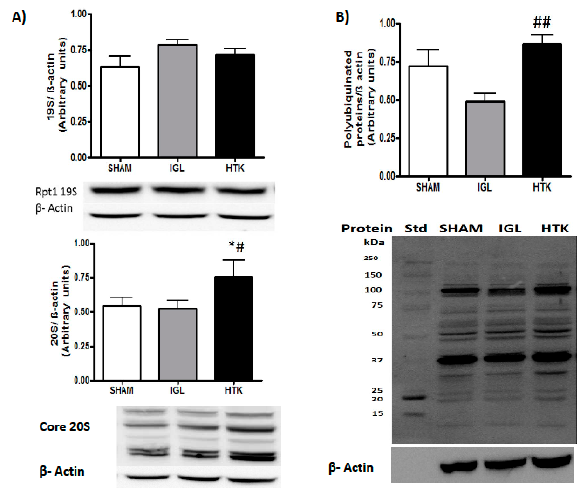
Figure 4. Proteasome 20S and 19S ( A ) and ubiquitinated protein level changes ( B ) in liver grafts preserved in IGL-1 and HTK solutions vs. SHAM. Results are expressed as mean ± SEM of n from 3 to 6 (SHAM n = 3; IGL-1 n = 6 and HTK n = 5). ( A ) Representative Western blots of 20S and 19S at the bottom and densitometric analysis at the top. * p < 0.05 versus SHAM and # p < 0.05 versus IGL-1. ( B ) The blot for ubiquitinated protein detection was stripped (using a mild stripping protocol) and reprobed for β -actin (using a different secondary, anti-rabbit for ubiquitin, anti-mouse for β -actin). Representative Western blots of ubiquitin at the bottom and densitometric analysis at the top. ## p < 0.01 versus IGL-1.